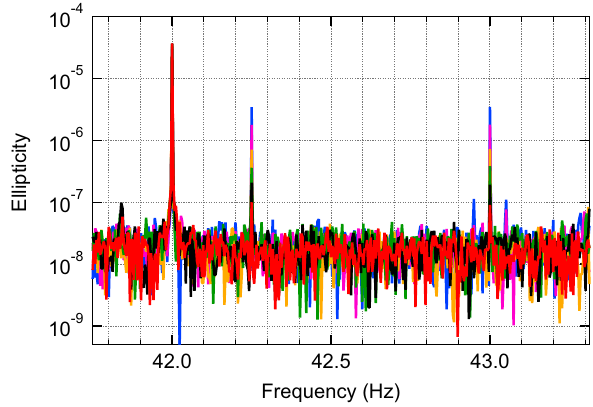
Fig. 11 Ellipticity spectra of the magnetic birefringence of six dif- ferent pressures of nitrogen gas taken with the wave plates rotating at ν P = 10 . 5 Hz and the magnets rotating at ν B α = 0 . 125 Hz and ν = 0 . 5 Hz B β